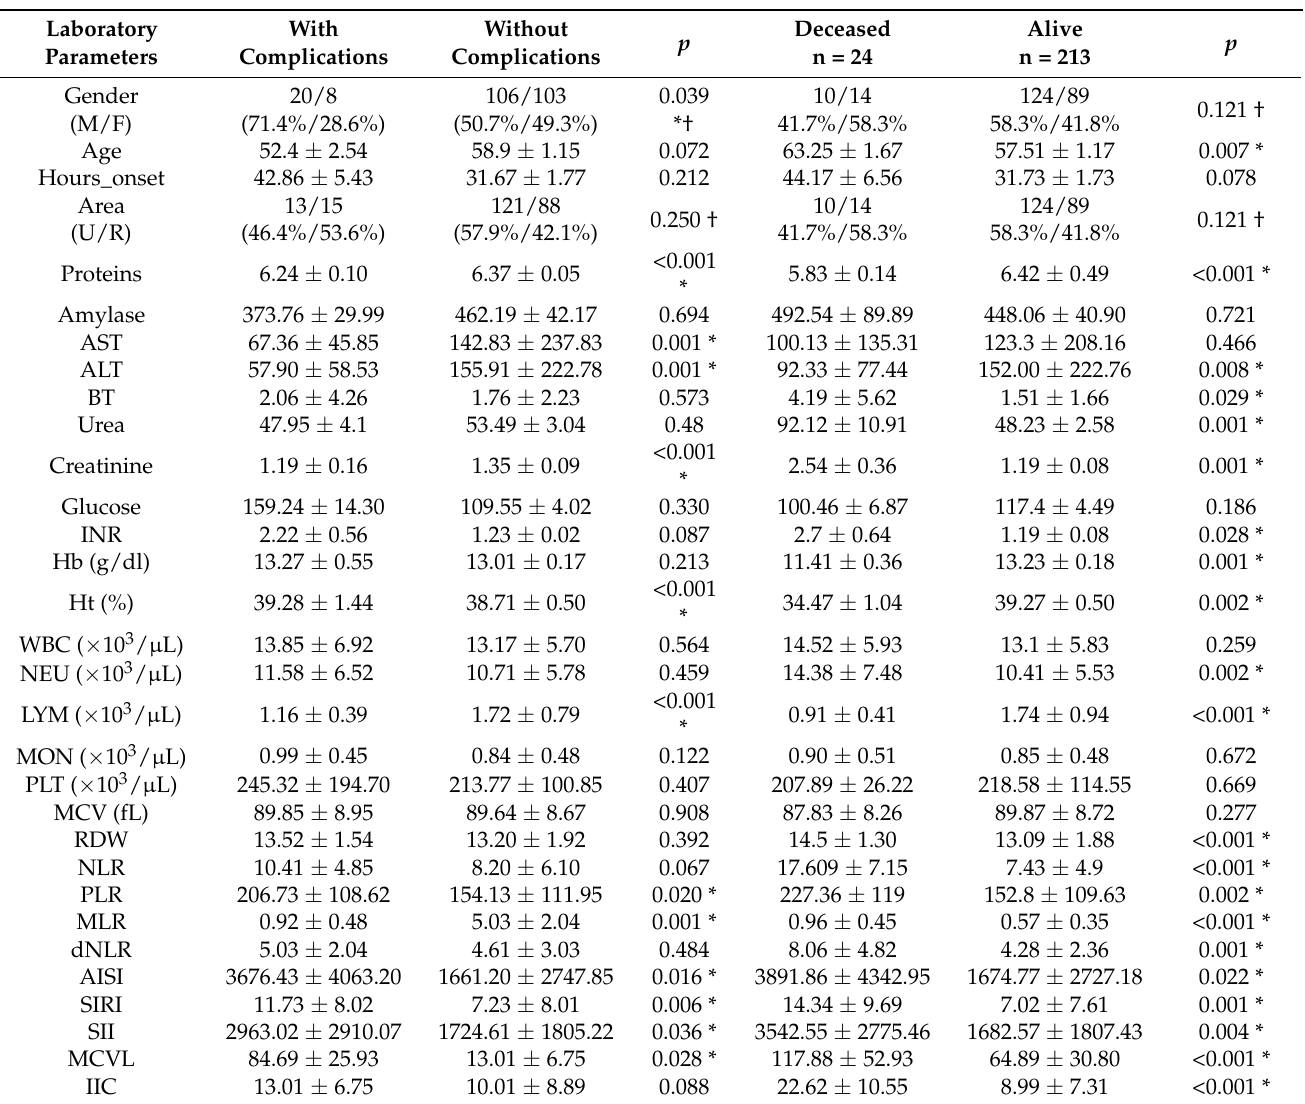
Table 5. Comparison of patients parameters according to complications and mortality in the pre- COVID